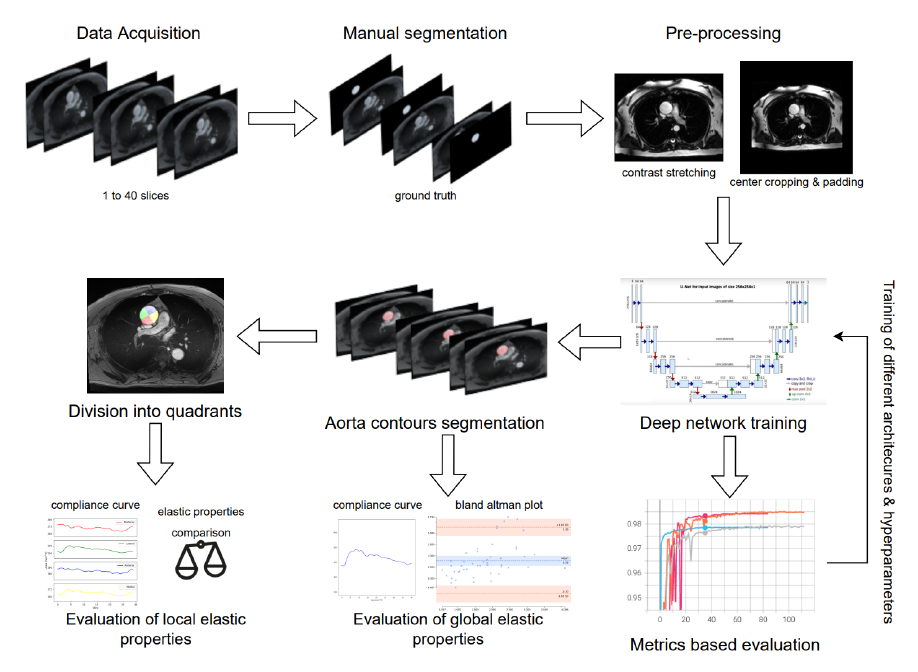
Figure 5. Workflow of the research